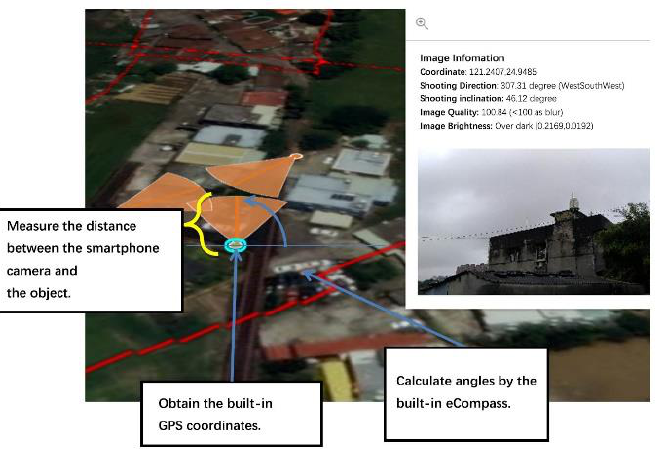
Figure 3. The crucial technique for the agricultural survey APP is to measure the distance between the camera and the object.